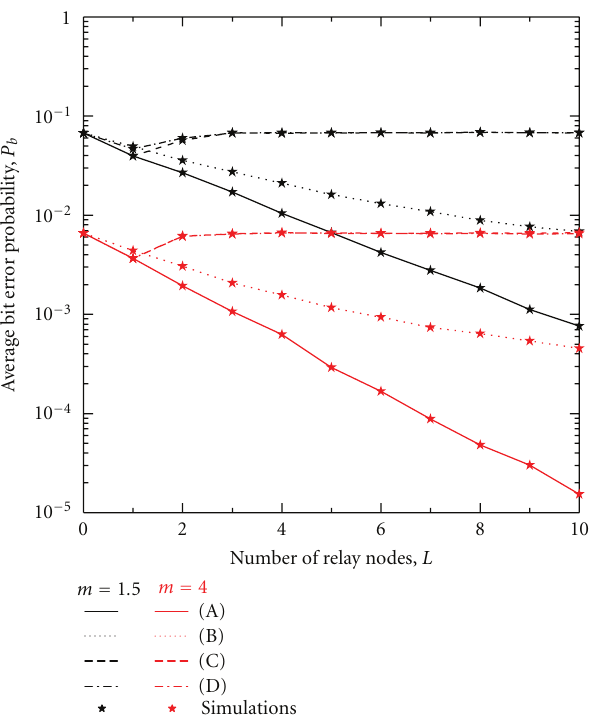
Figure 6: ABEP, P b , of square 4-QAM versus the number of relay nodes, L , for average transmit SNR γ over IID Nakagami- m fading channels with di ff erent values of m : (A) pure RS, (B) rate-selective RS, (C) repetitive transmission with MRD, and (D) repetitive transmission with SD.